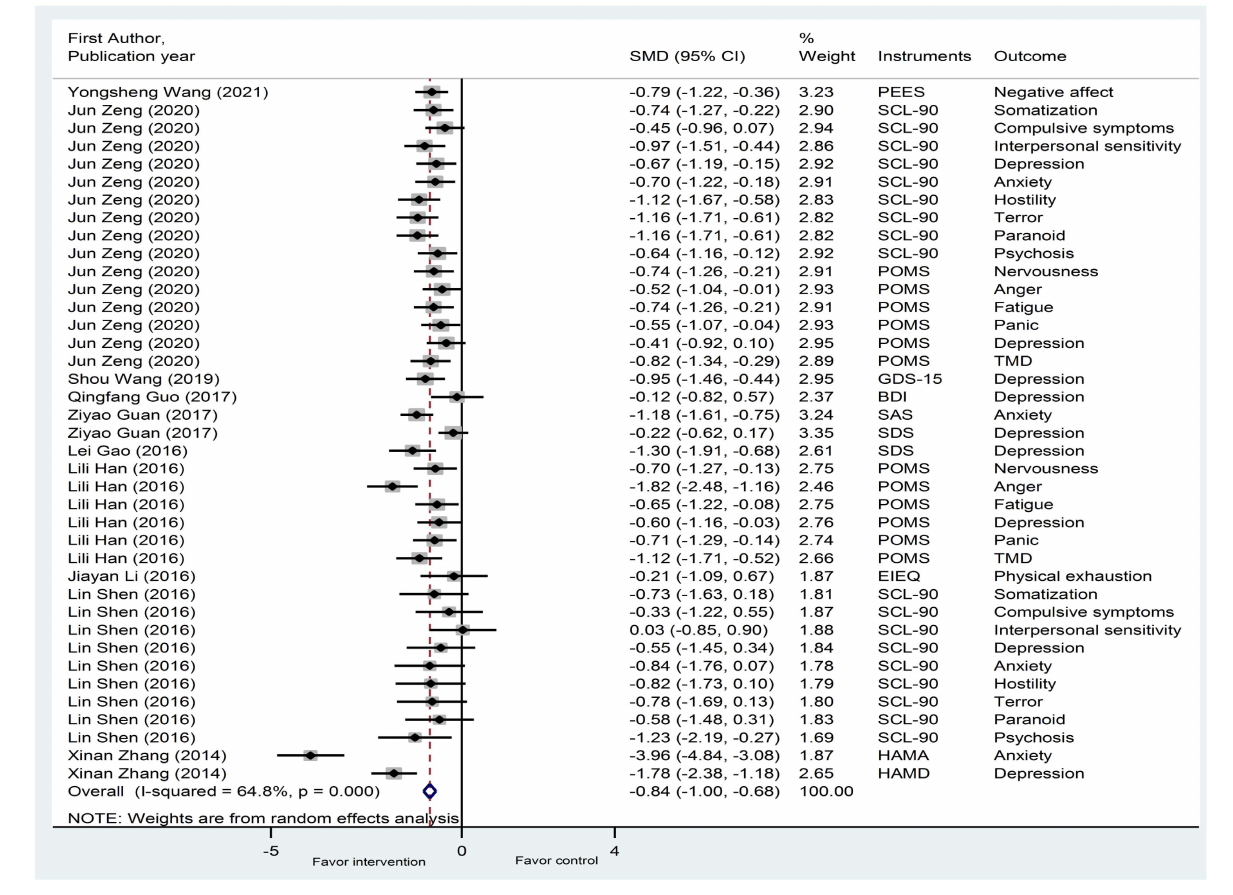
FIGURE 3 | A meta-analysis of the effectiveness of plaza dancing on psychological ill-being. Three studies reported results for psychological ill-being, and seven studies reported results for both psychological well-being and ill-being. The results from 10 studies on psychological ill-being (reporting 39 analyses, including different related outcomes) were included. The random-effects model was used, as it assumes that varying effect sizes between the studies are due to the differences in the study content and population. Positive effect size values indicate lower scores for psychological ill-being in favor of the intervention. BDI, Beck Depression Inventory; CSS, Core Self-Evaluation Scale; EIEQ, Exercise-Induced Emotion Questionnaire; GDS-15, 15-item Geriatric Depression Scale; GWB, General Well-Being Schedule; HAMA, Hamilton Anxiety Scale; HAMD, Hamilton Depression Scale; LSIA, Life Satisfaction Index A; PEES, Post-Exercise Emotional Experience Scale; POMS, Profile of Mood States; PSPP, Platform Sizing and Performance Program; SAS, Self-Rating Anxiety Scale; SCL-90, Symptom Check List 90; SDS, Self-Rating Depression Scale; SES, Self-Esteem Scale; SF-36, the MOS item short-form health survey; TMD, total of motional